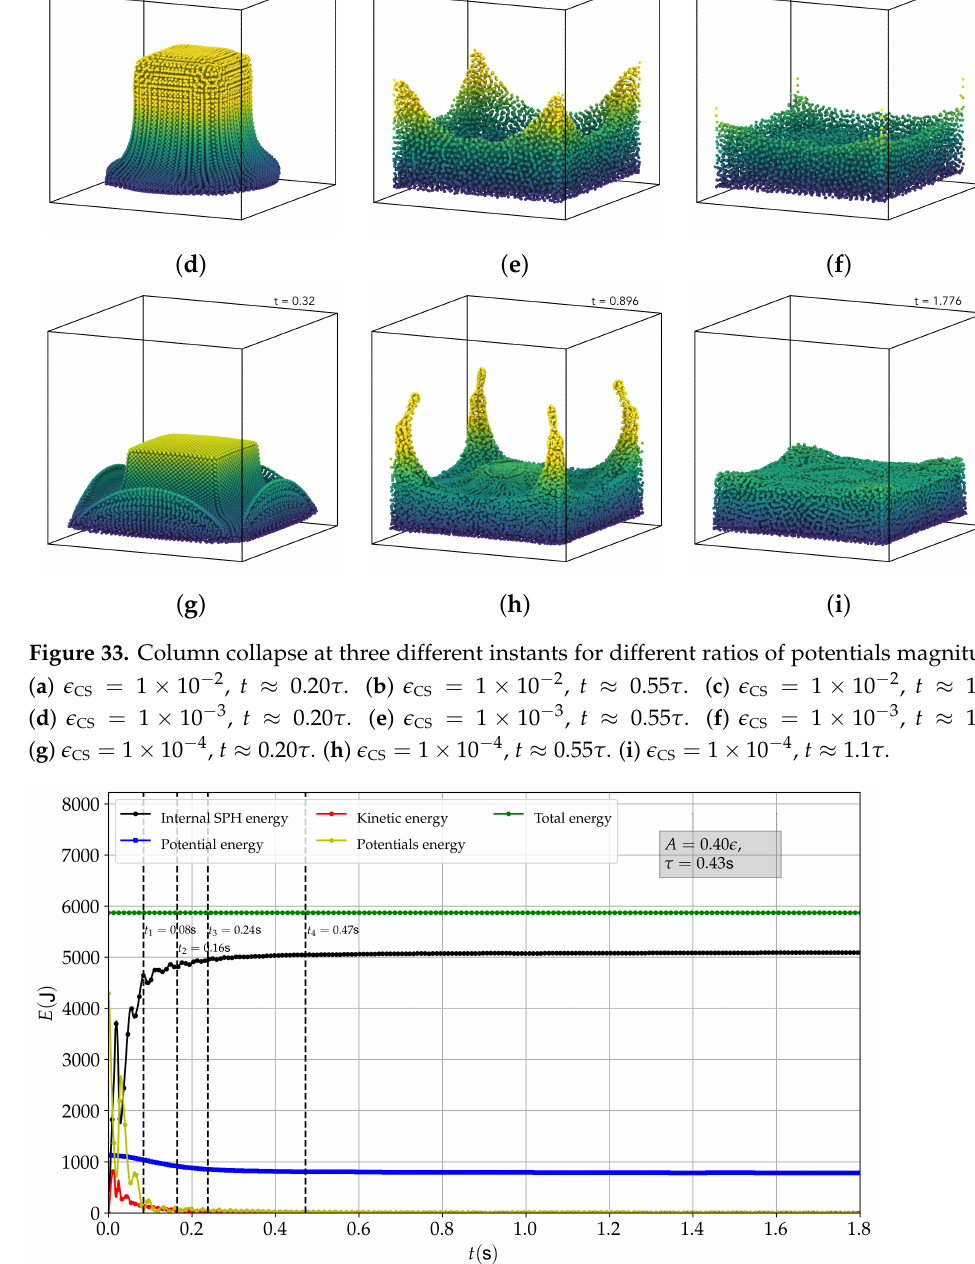
Figure 34. Energy budget vs. time for a “mostly” elastic substance. (cid:101) CS = 1 × 10 − 2 , A = 0.4 (cid:101) CS